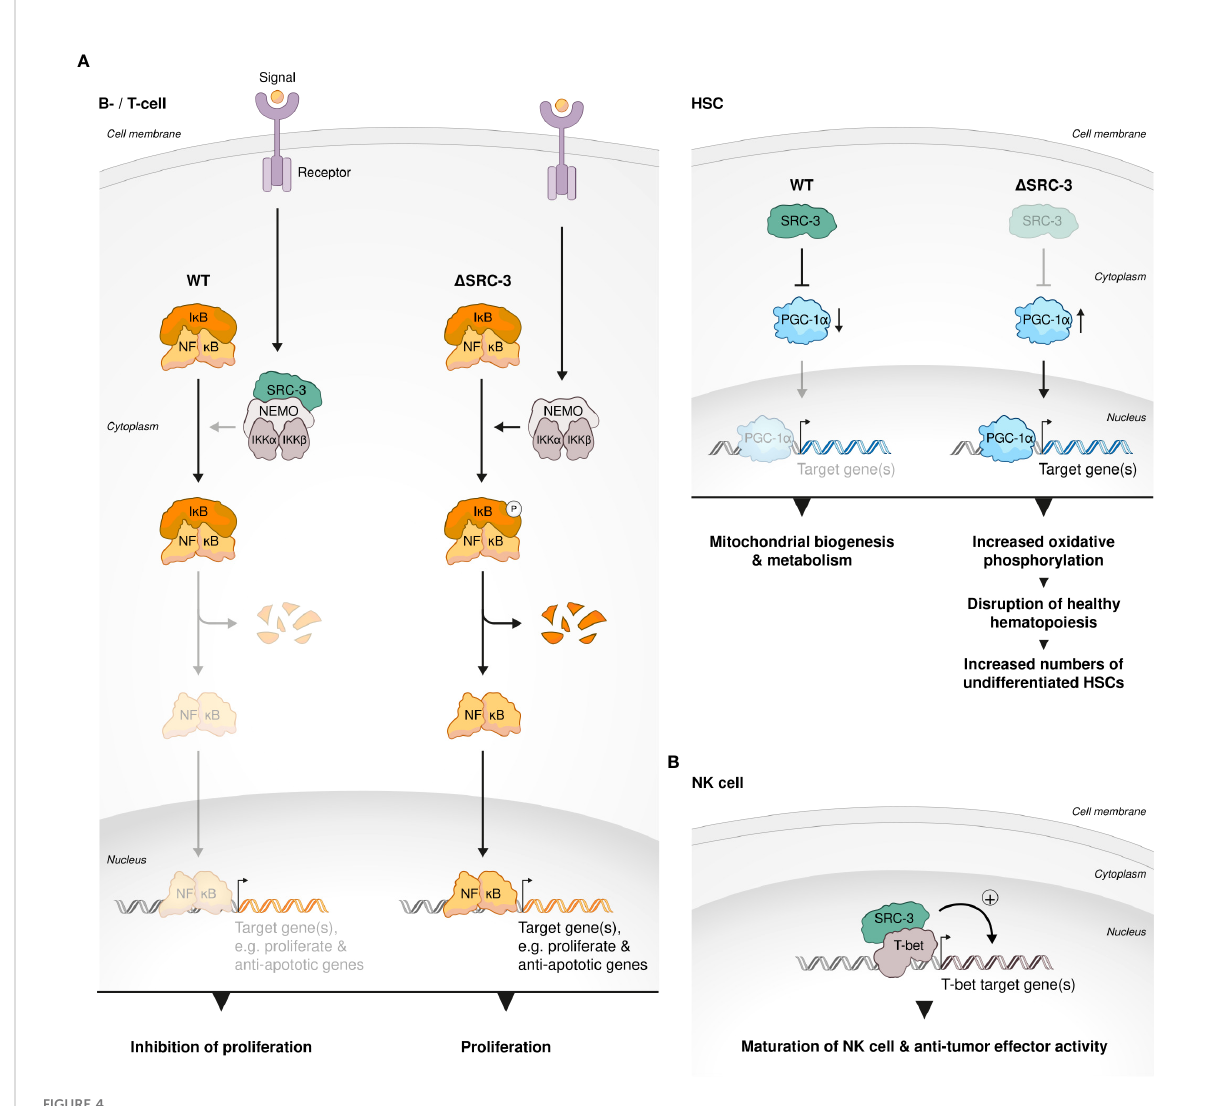
FIGURE 4 SRC-3 role in lymphocyte development. (A) SRC-3 plays an anti-proliferative role in early developing immune cells. SRC-3 selectively inhibits the proliferation of lymphoid cells in a cell autonomous manner: T and B cells isolated from SRC-3 KO mice showed an increased ex vivo proliferation compared to their WT counterparts (left). SRC-3 is required for maintaining the quiescent state of HSCs: lack of SRC-3 results in increased proliferation of HSCs. SRC-3 de fi ciency in murine HSCs results in an upregulated activity of PGC-1 a (the master regulator of mitochondrial biogenesis and metabolism) an consequent disruption of normal HSC function and healthy hematopoiesis (right). (B) SRC-3 is important for healthy development of HSCs, NK and Treg cells. SRC-3 is a critical factor in lineage development and effector function of NK cells: SRC-3 is recruited to the promoter regions of prominent T-bet binding sites in WT but not SRC-3 KO NK